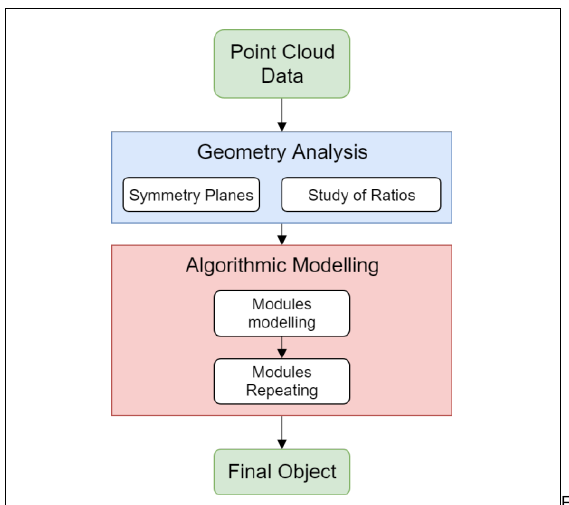
Figure 5. A single algorithm can generate several models just changing input parameters